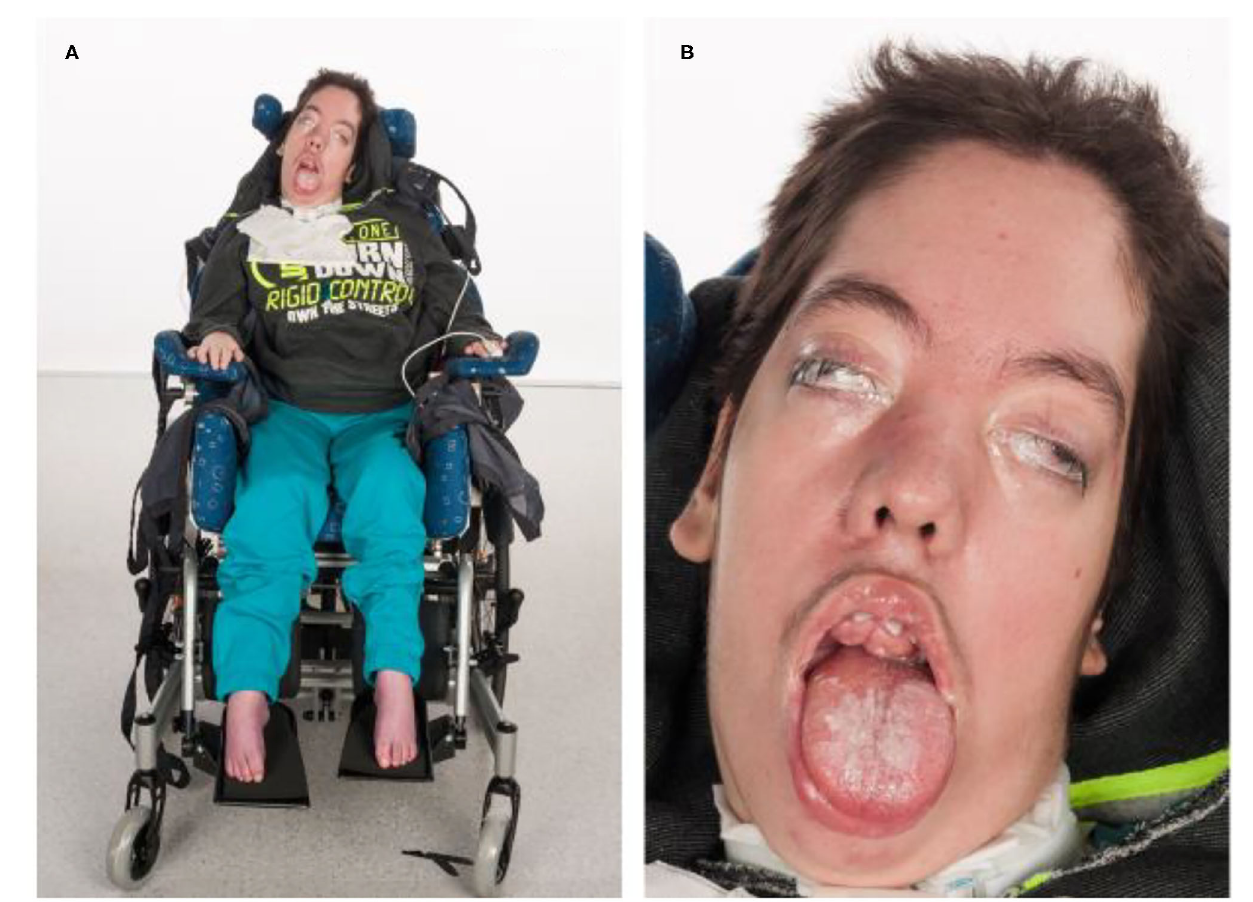
FIGURE 3 | Phenotype of patient I at the age of 15 years. (A) Severe global muscular hypotonia, scoliosis, talipes equinus. (B) Facial dysmorphias: Long drawn face with a high forehead, hypertelorism and exophtalmus, opened mouth, macroglossia, gingiva hyperplasia with teeth anomalies, small philtrum, and prominent